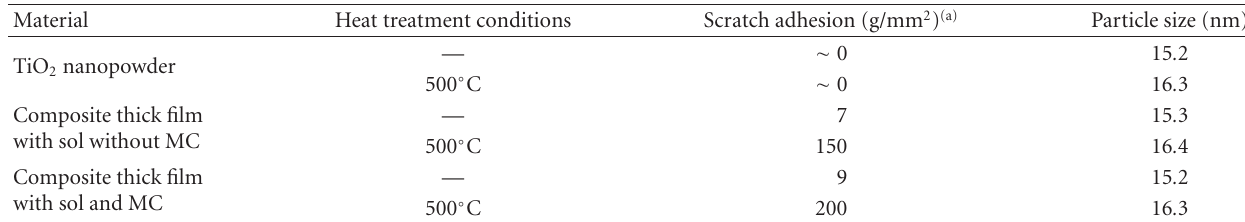
Table 1: Physical and chemical characteristics of composite TiO 2 film, compared to TiO 2 nanopowder. Material